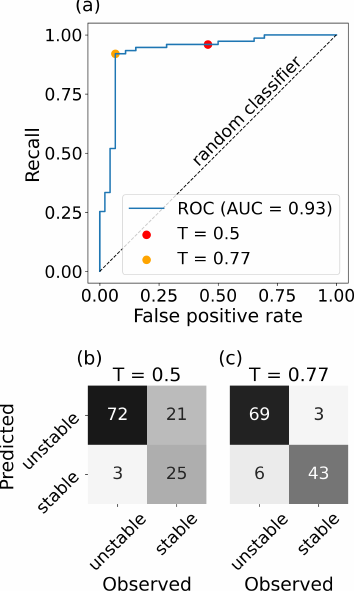
Figure 10. (a) ROC curve analysis and (b,c) contingency tables for the classification of the unstable and stable classes from the SWISS data set, using the maximum value of the probability of instabil- ity, P max . Contingency tables are shown for (b) the default threshold ( T = 0 . 5, red dot in a ) and (c) the optimized threshold ( T = 0 . 77, orange dot in a ) obtained from the ROC curve analysis. Table 2. Performance measures for the classification of profiles from the SWISS data set based on the maximum value of the proba- bility of instability ( P max ) for different classification thresholds ( T ): 0.5 (default), 0.71 (optimized value for the classification of manu- ally selected weak layers) and 0.77 (optimized value for the classi- fication based on P max ).